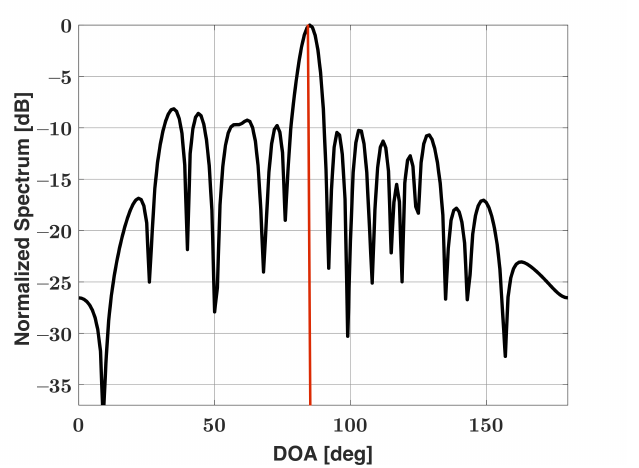
Figure 2. Residual Bartlett spectra for a uniform linear array of 15 elements in the presence of two signals incident at 60 ◦ (25 dB SNR) and 85 ◦ (0 dB SNR): the estimated signal incident at 60 ◦ with an SNR of 25 dB has been